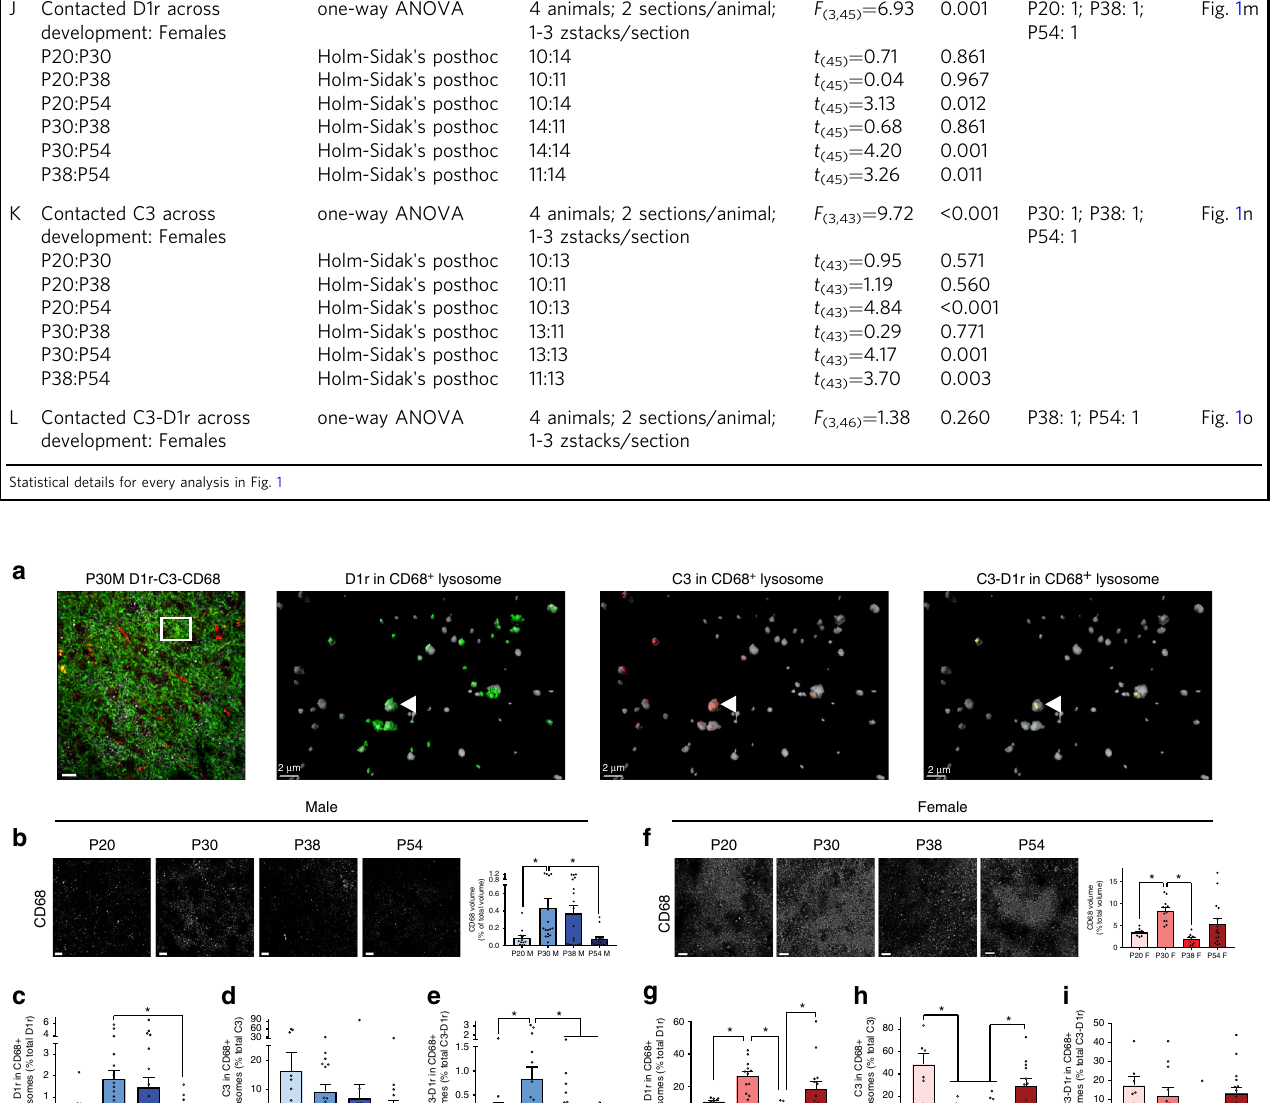
Fig. 2 D1r downregulation in adolescence is associated with complement C3 and microglial lysosomal degradation in the male, but not the female, NAc. To assess microglial phagocytic activity and whether D1r, C3, or C3-D1r were localized in microglial CD68 + lysosomes, immunohistochemistry for CD68, D1r, and C3 was performed. a Representative 2D triple-label immunohistochemistry (scale bar 20 µ m), with enlarged 3D representation (scale bar 2 µ m) of the selected area demonstrating (left-right) D1r, C3, and C3-D1r within CD68 + lysosomes. Closed arrow head indicates a lysosome where D1r and C3 colocalize (C3-D1r). Males: c CD68 levels are high from P30 to 38 (Table 2A). b D1r content in CD68 + lysosomes is highest at P30 (Table 2B), d C3 content in lysosomes does not change over development (Table 2C), and e C3-D1r content in lysosomes is transiently elevated at P30 (Table 2D). Females: f CD68 levels are transiently elevated at P30 (Table 2E). g D1r content in CD68 + lysosomes is high at both P30 and P54 (Table 2F), h C3 content in lysosomes is highest at P20 and P54 (Table 2G), and i C3-D1r content in lysosomes does not change over development (Table 2H). For all experiments, n = 4 animals/sex/group. Data were analyzed with one-way ANOVAs and Holm-Sidak ’ s post-hoc comparisons. Histograms portray the mean ± SEM with individual data points overlaid. Signi fi cant post-hoc Holm-Sidak t -tests ( p < 0.05) comparisons are delineated with an asterisk. All statistics are in Table (similar to previously described assessment of microglial contact), D1r (Fig. 2c; Table 2B) and colocalized C3-D1r (Fig. 2e; Table 2D) content within lysosomes was highest at P30 and P38 in males.